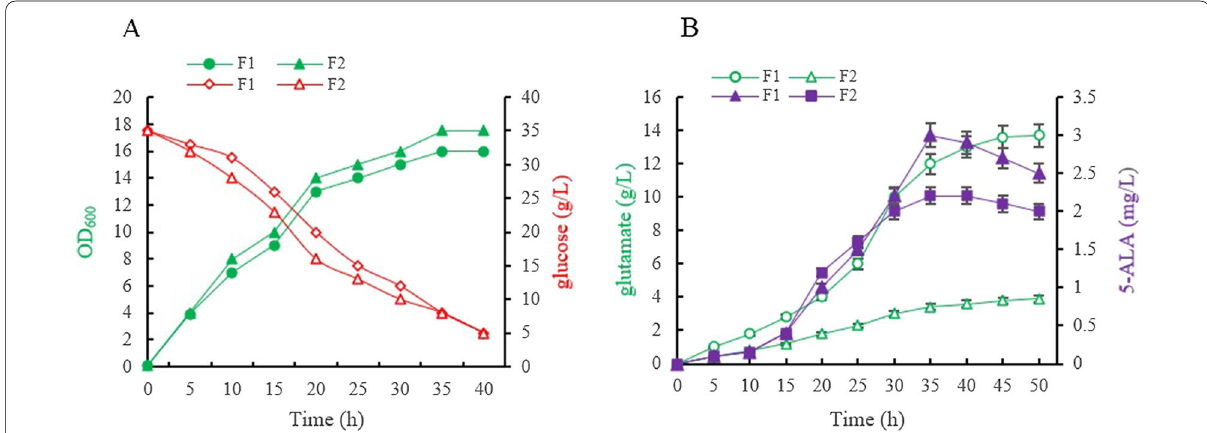
Fig. 1 The growth and glucose consumption ( A ), the accumulation of 5-ALA and glutamate ( B ) in C. glutamicum strains F1,